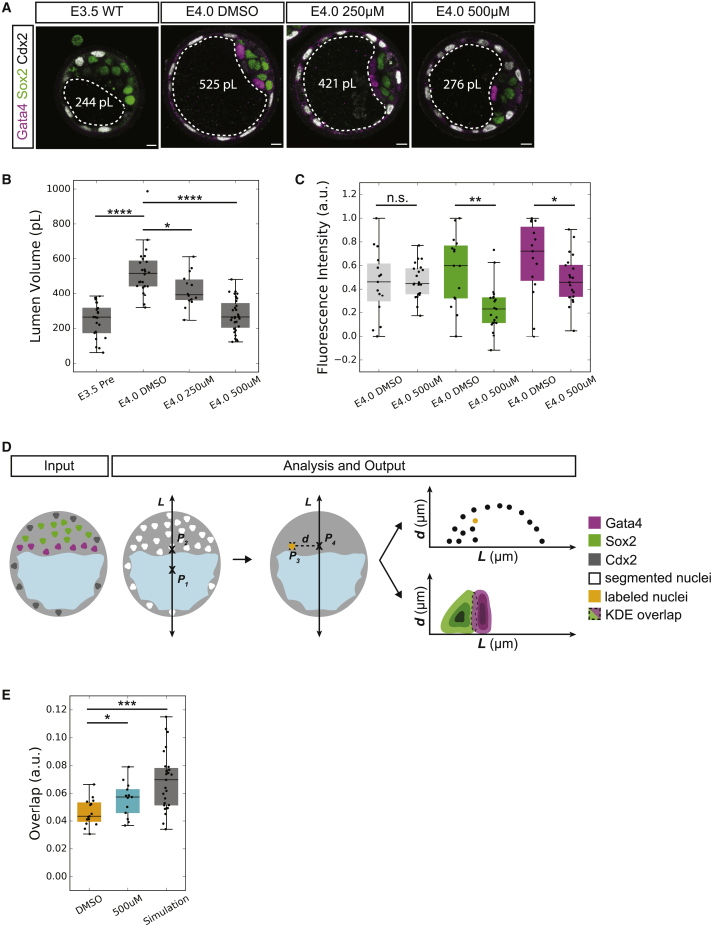
EPI and PrE Expression Levels Are Reduced in ATP1-Inhibited Embryos(A) Immunofluorescence images of TE (Cdx2), EPI (Sox2), and PrE (Gata4) fate in pre-treatment control (E3.5 WT), Atp1 inhibited (E4.0 500 μM and E4.0 250 μM), and end-stage control (E4.0 DMSO) embryos. Lumen boundaries outlined by dashed white line and mean lumen volume in white text. Scale bars, 10 μm.(B) Boxplot of lumen volume for E3.5 WT (N = 21), E4.0 DMSO (N = 24), E4.0 250 μM Atp1 inhibited (N = 14) and E4.0 500 μM Atp1 inhibited (N = 31) embryos indicating that the impact on lumen volume is concentration dependent.(C) Boxplot of fluorescence levels of Cdx2 (gray), Sox2 (green), and Gata4 (magenta) in E4.0 500 μM Atp1 inhibited embryos compared to E4.0 DMSO controls.(D) Schematic 2D representation of 3D analysis method for spatial segregation of ICM lineages. P1,2,3,4 are 3D points. L↔ is a 3D line (P1P2↔ equivalent) that defines the embryonic-abembryonic axis. d‾ is the 3D line segment (P3P4‾ equivalent) that measures the perpendicular distance from the center of a cell to L↔. See Image Analysis for formal definitions of all geometric entities.(E) Boxplot of spatial overlap between EPI and PrE lineages within E4.0 control (DMSO, N = 15), E4.0 Atp1 inhibited (500 μM, N =13) and simulated data of maximal overlap in E4.0 WT embryos (Simulation, N = 27).∗∗∗∗p < 0.0001, ∗∗∗p < 0.001, ∗∗p < 0.01, ∗p < 0.05. n.s., not significant.For boxplots: central mark indicates the median; lower edge, 25%; upper edge, 75%; lower whisker, Q1 − (1.5 × IQR), where IQR = Q3 − Q1; upper whisker, Q3 + (1.5 × IQR).See also Figures S4 and S5; Table S2.